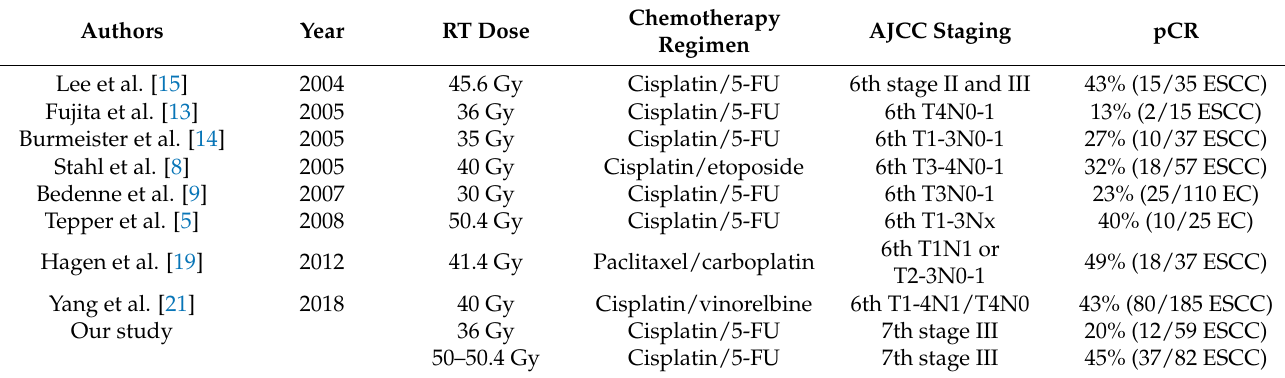
Table 7. Clinical series of patients with esophageal cancer receiving preoperative